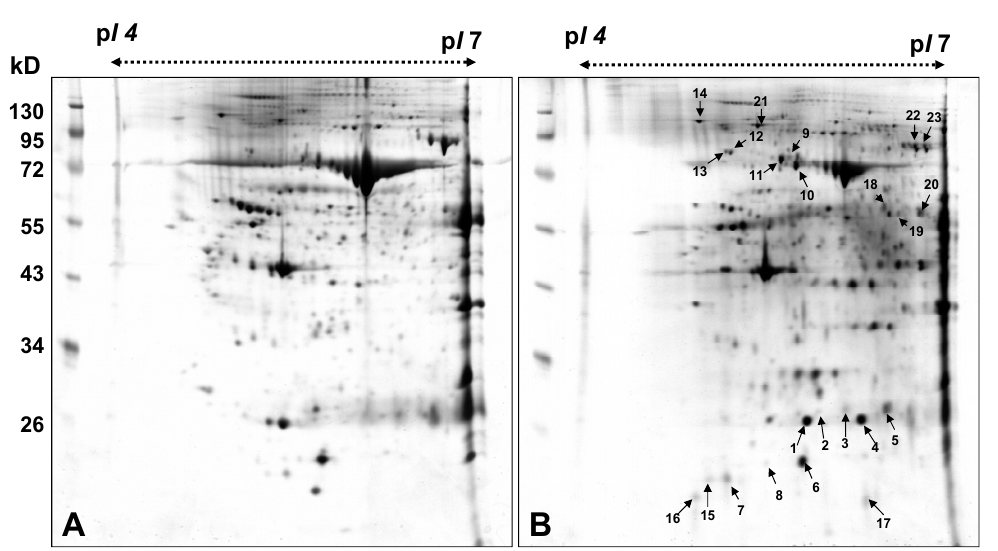
Table 1. The five protein spots (No. 1–5) with a molecular weight of 27 kDa were identified as different species of heat shock protein 27 (HSP27). The protein spots (No. 6–8) below HSP27 were identified as peroxiredoxin-2 (PRDX2). All 2-DE maps of twelve patients are shown in Supplementary Figure 1. Figure 1. 2-DE maps of ( A ) cholesteatoma tissues (pI 4–7) and ( B ) retroauricular skin